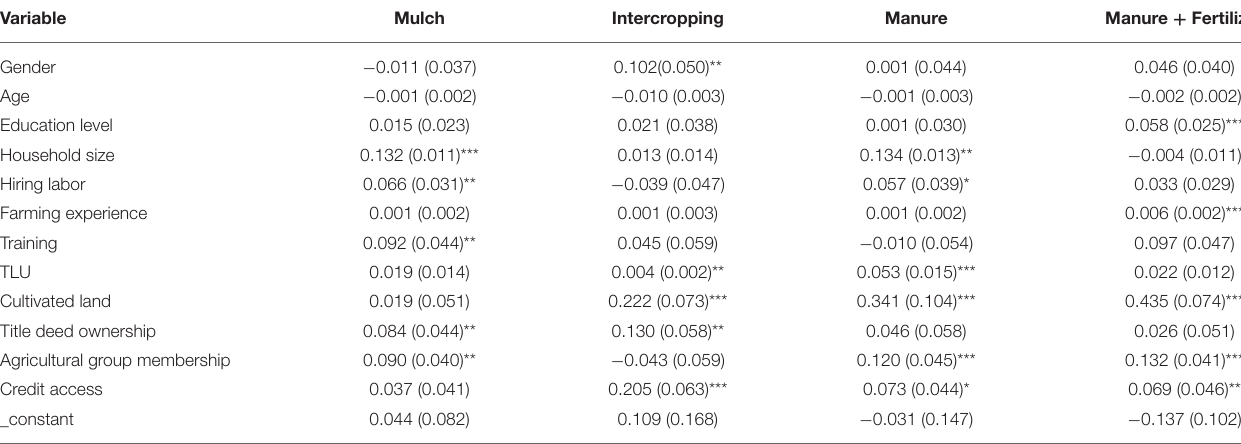
TABLE 8 | Parameter estimates of the Tobit model for the determinants of adoption intensity of the selected organic-based technologies in Tharaka-Nithi County. Variable